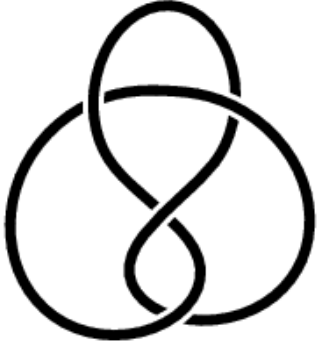
Figure 3. figure-8 knot 4 1